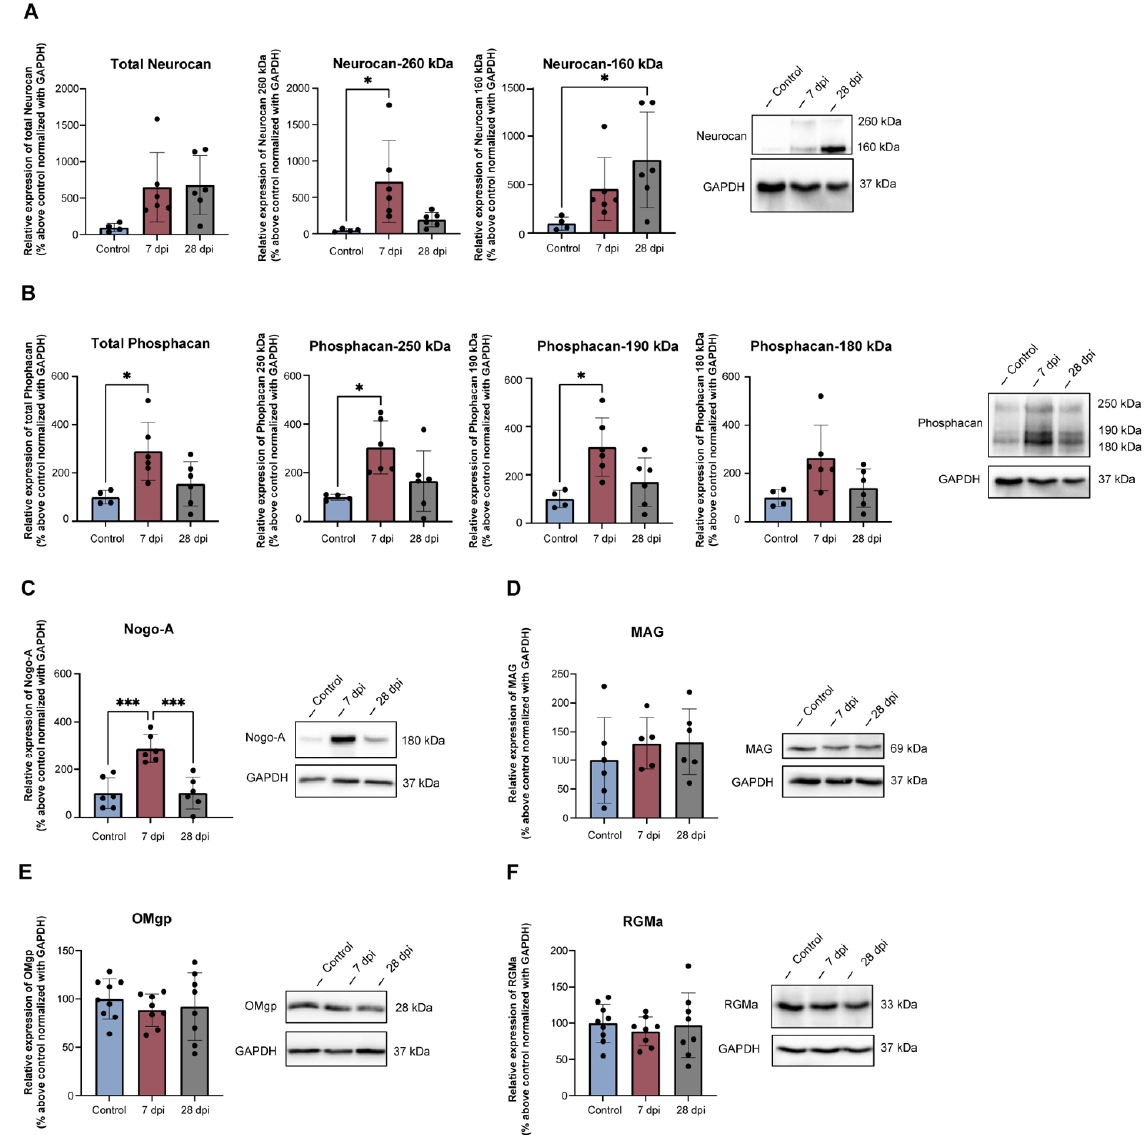
Figure 3. Time-dependent changes in repulsive proteins expression after thoracic spinal cord injury. Western blots of Neurocan ( A ), Phosphacan ( B ), Nogo-A ( C ), MAG ( D ), OMgp ( E ) and RGMa ( F ) and respective ratio against the endogenous protein GAPDH at the lumbosacral spinal cord in spi- nal intact animals (control) and after SCT. Total Neurocan (A) expression did not show any signifi- cant differences between controls and SCT animals, but Neurocan-250 significantly increased 7 dpi and Neurocan-160 increased significantly 28 dpi. Total Phosphacan ( B ) and Nogo-A ( C ) expression significantly increased 7 dpi (days post-injury), decreasing at 28 dpi. Expression of MAG ( D ), OMgp ( E ) and RGMa ( F ) was not changed by the thoracic lesion. Graphs represent mean ± SD and p < 0.05 was considered statistically significant. * p ≤ 0.05; *** p ≤ 0.001; one-way ANOVA followed by Tukey’s multiple comparison test.